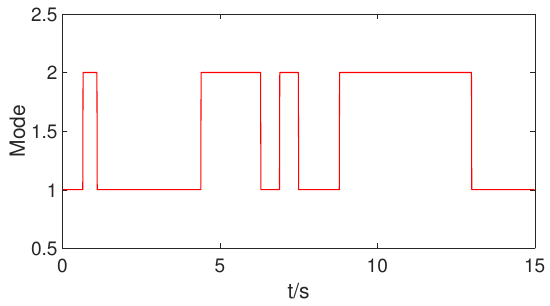
Figure 1. Transition